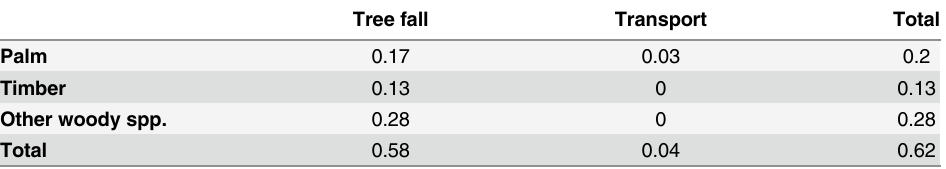
Table 3. Residual stand damage from monitored timber extraction in terms of basal area (m 2 ) of trees > 5 cm DBH killed by basal area (m 2 ) of timber